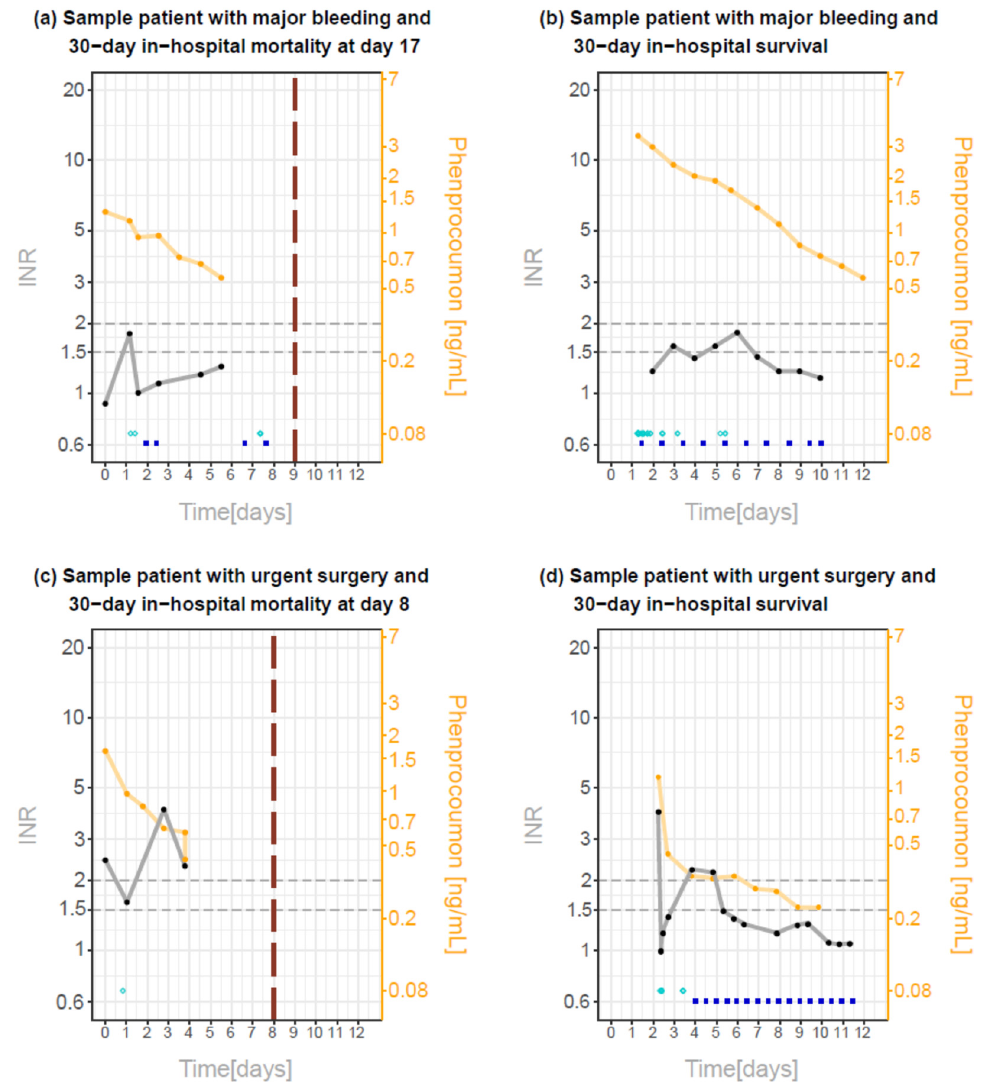
Figure 1. Pharmacokinetic phenprocoumon (orange dots and lines) and INR (black dots and lines) measurements over time in exemplary patients with major bleeding (Panel ( a , b )) and with urgent surgery (Panel ( c , d )). Patients in Panel ( a , c ) died during hospital stay, the vertical dashed line indicates the time of death. Blue filled circles (vitamin K) and cyan open circles (PCC) indicate the treatment time with vitamin K and PCC, respectively. Horizontal dashed lines mark INR levels of 1.5 and 2.0 as reference.